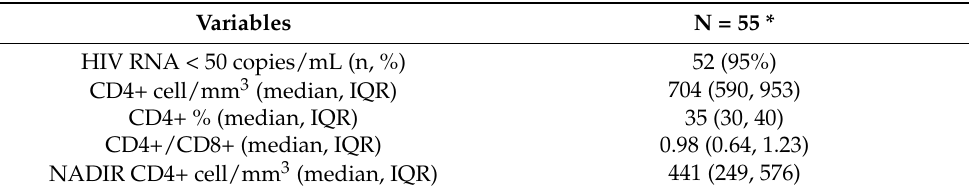
Table 2. Laboratory values in PLWH diagnosed with mpox.